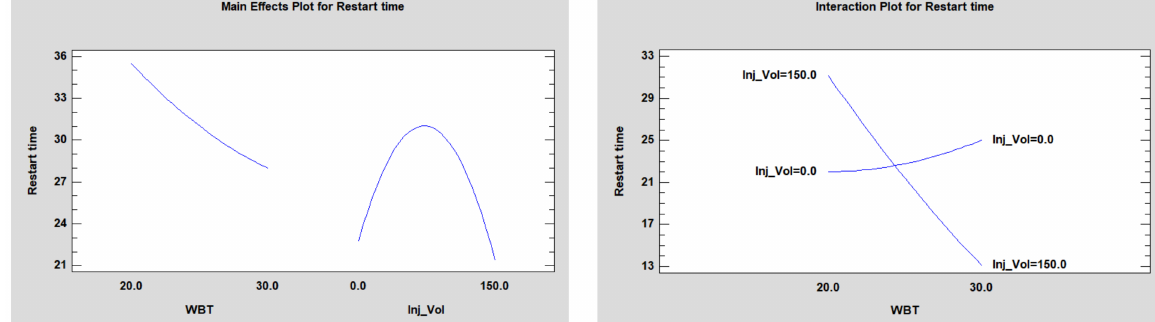
Figure 5. Main effect and interaction plots for the restart time during the instantaneous